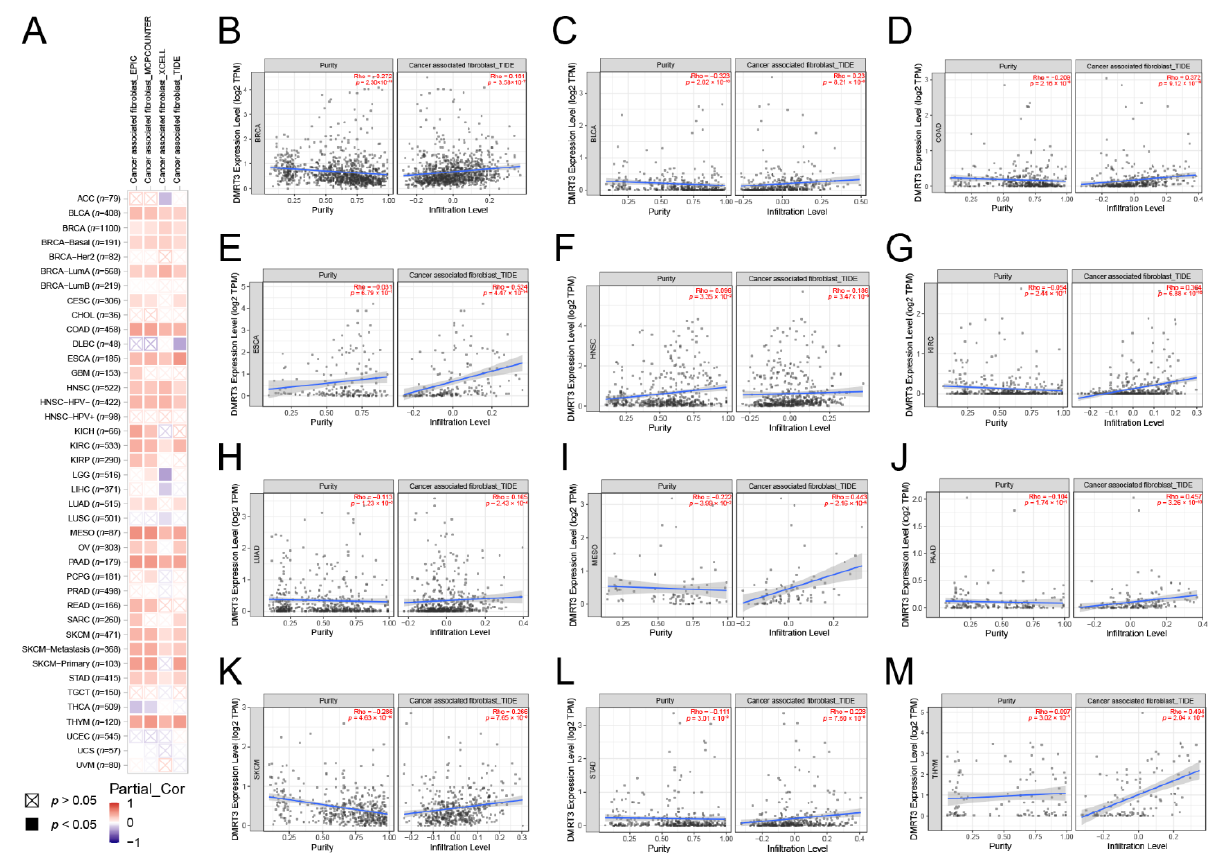
Figure 7. Correlation of the DMRT3 expression with cancer-associated fibroblasts (CAF) in pan-cancer tumors. ( A ) Correlation analysis between the DMRT3 expression and CAF was performed using TIMER2.0. ( B ) BLCA. ( C ) BRCA. ( D ) COAD. ( E ) ESCA. ( F ) HNSC. ( G ) KIRC. ( H ) LUAD. ( I ) MESO. ( J ) PAAD. ( K ) SKCM. ( L ) STAD. ( M ) THYM.